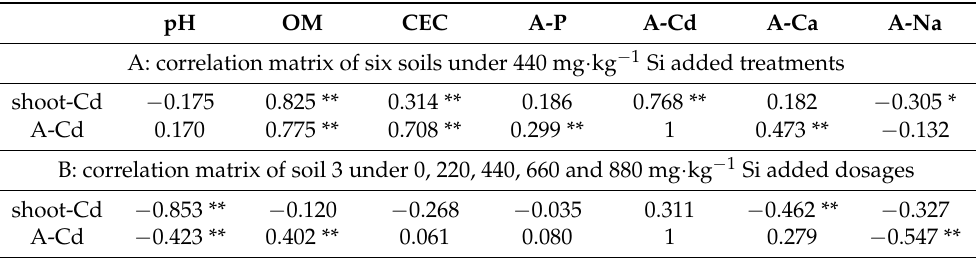
Figure 4. Effects of amendments on the fraction changes of Cd in 440 mg · kg − 1 Si amended six soils ( A ) and in soil 3 under 0, 220, 440, 660, and 880 mg · kg − 1 Si added dosages ( B ). Control, non-amendment treatment; MS, 4A molecular sieve; WS, wollastonite. F1—exchangeable fraction, F2—bound to carbonates/acid soluble fraction, F3—bound to iron and manganese oxides/reducible fraction, F4—bound to organic matter/oxidizable fraction, and F5—residual fraction. Table 4. Pearson’s correlation coefficients among soil chemistries, soil Cd availability, and Cd concentrations in